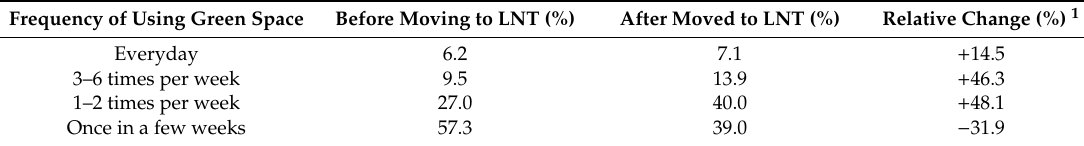
Table 2. Relative change of green space use, before and after residents moving to LNT.